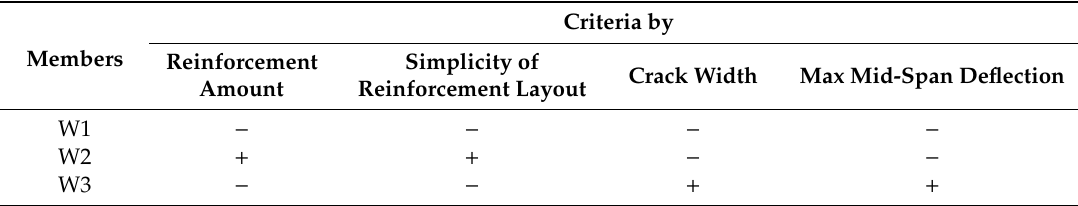
Table 8. The selecting of optimal solution.